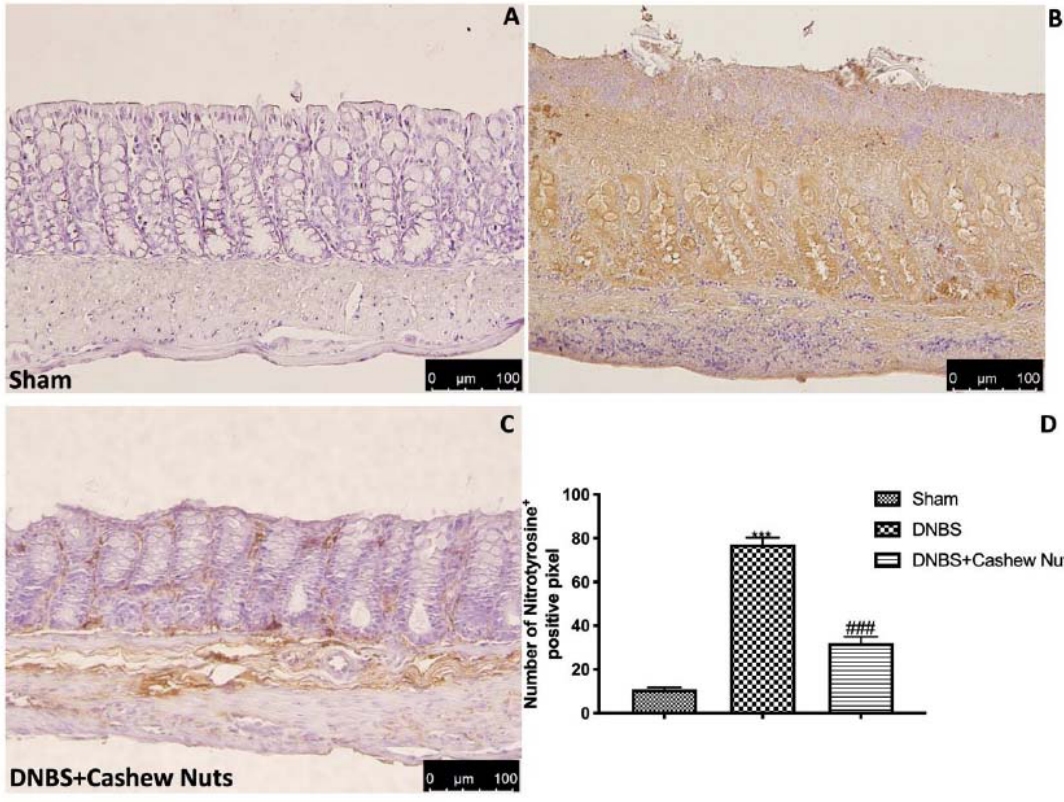
Figure 6. The e ff ects of cashew nuts on nitrotyrosine expression after DNBS injection. Immunohistochemistry for nitrotyrosine was evaluated in sham ( A ), DNBS ( B ), DNBS + cashew nuts ( C ). Results are expressed as % of positive pixels ( D ). Images are figurative of at least three independent experiments. Values = means ± SEM of six animals in each group; *** p < 0.001 vs. sham; ### p < 0.001 vs.